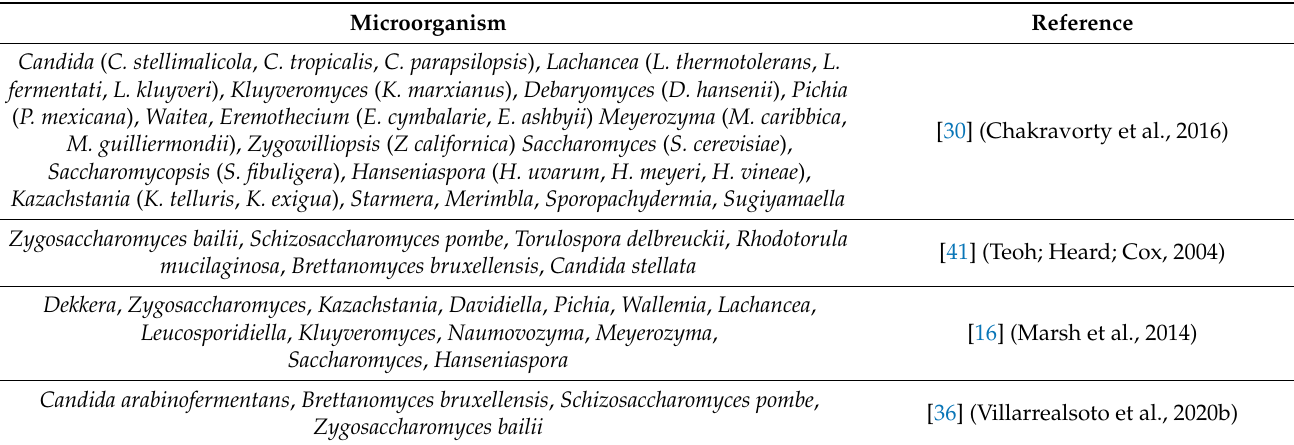
Table 2. Some genera and species of yeast found in kombuchas.